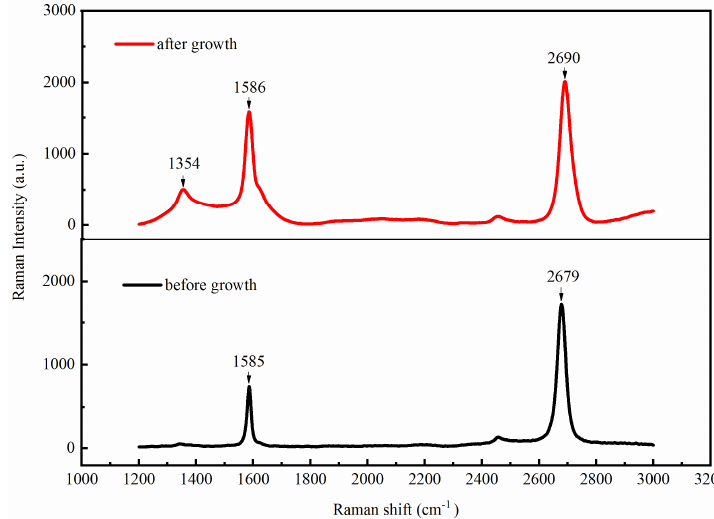
Figure 4. The Raman spectra of graphene’s responses before and after MOCVD growth.